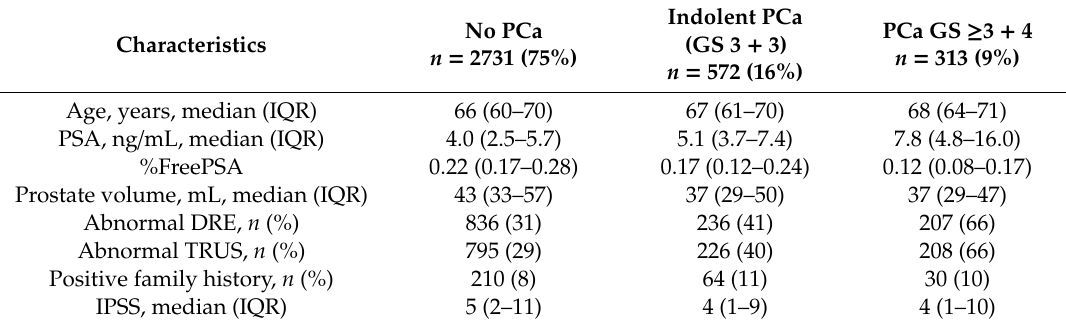
Table 1. Characteristics of 3616 men with a biopsy stratified to prostate cancer outcome from the European Randomized Study of Screening for Prostate Cancer (ERSPC).